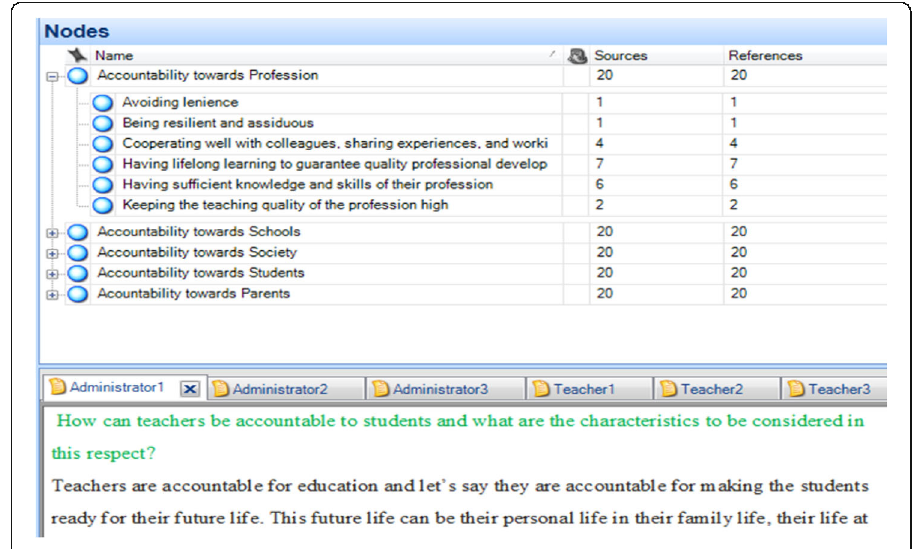
Fig. 2 Sample screen print of the nodes specified using Nvivo software